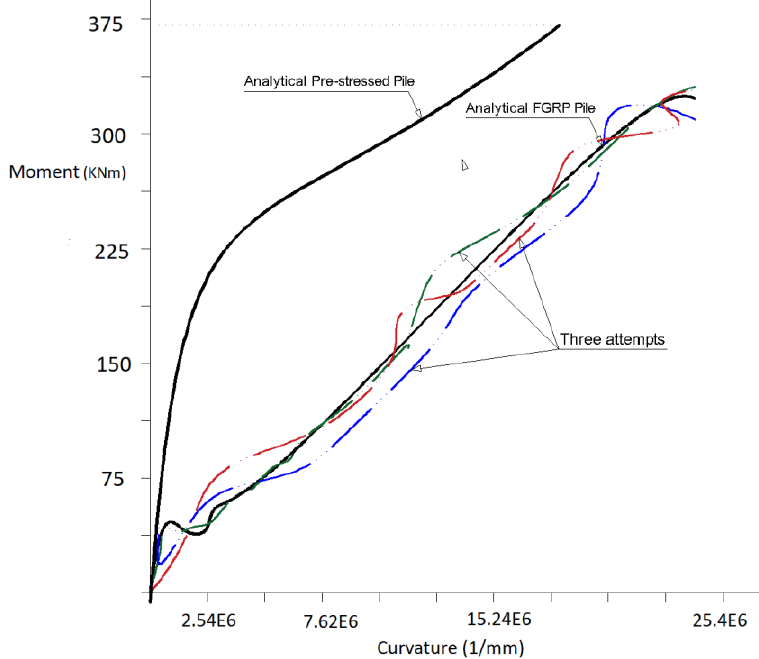
Figure 5. Moment-curvature analogy of eccentrically loaded column specimens reinforced with GFRP tubes compared to the analytical pre-stressed model.